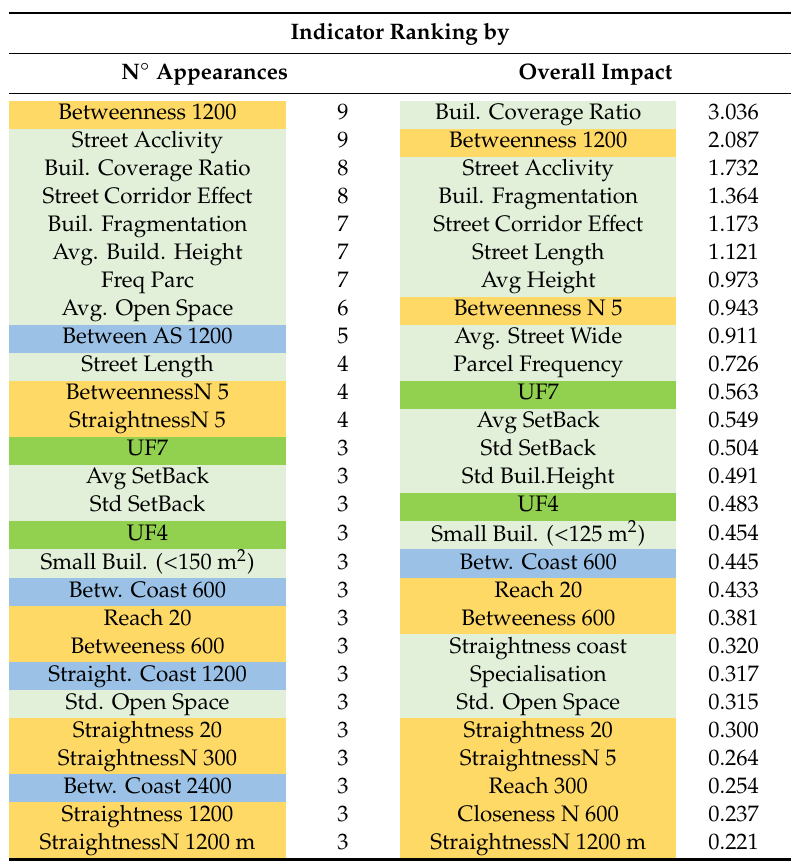
Table 5. Outcomes of feature selection procedures. Selection frequencies of the most recurrent descriptors of urban form in relation to micro-retail spatial